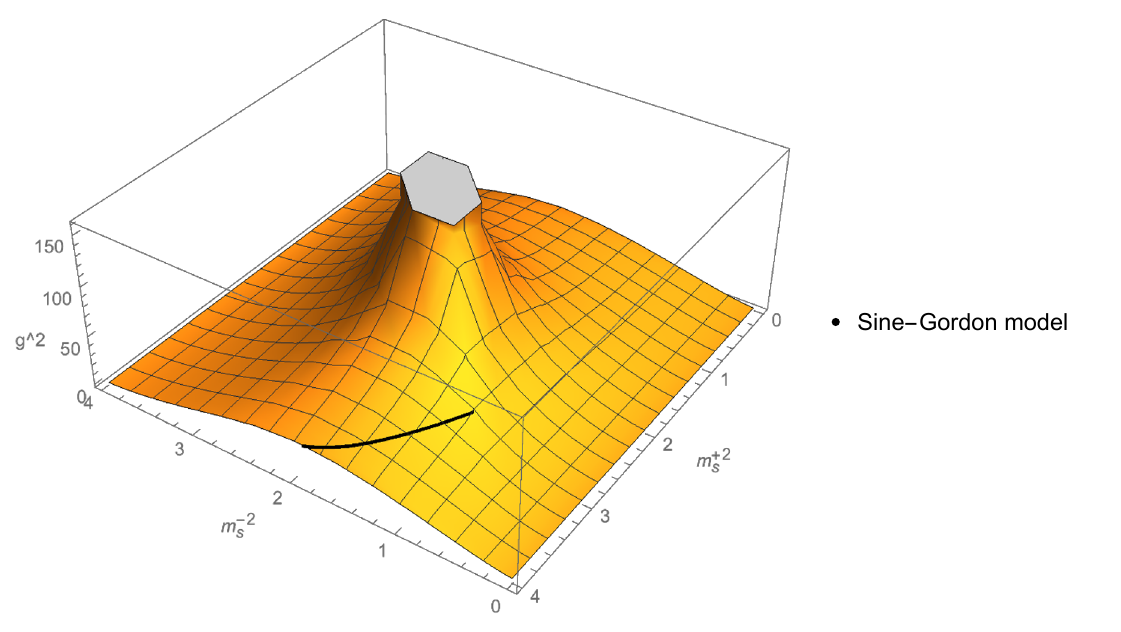
Figure 15 . O(2) bound on the coupling to an antisymmetric tensor particle state in the presence of a scalar bound state. Although it is hard to see in the (cid:12)gure, the bound is not smooth along the line m 2 + m 2 = 4, i.e. when the scalar pole and antisymmetric tensor poles collide with each other’s s a cross channel. The solid curve corresponds to the sine-Gordon model with the same spectrum, i.e. for (cid:25)= 2 (cid:20) (cid:24) (cid:20) (cid:25) .